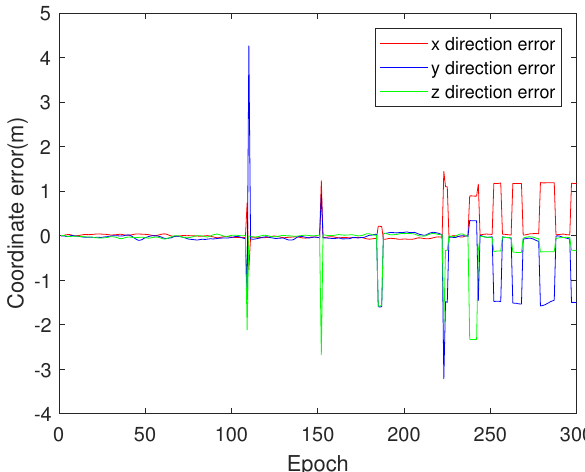
Figure 3. Coordinate identification error with LAMBDA (baseline 1).